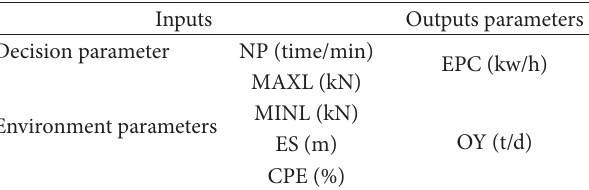
Table 1: Parameters used for